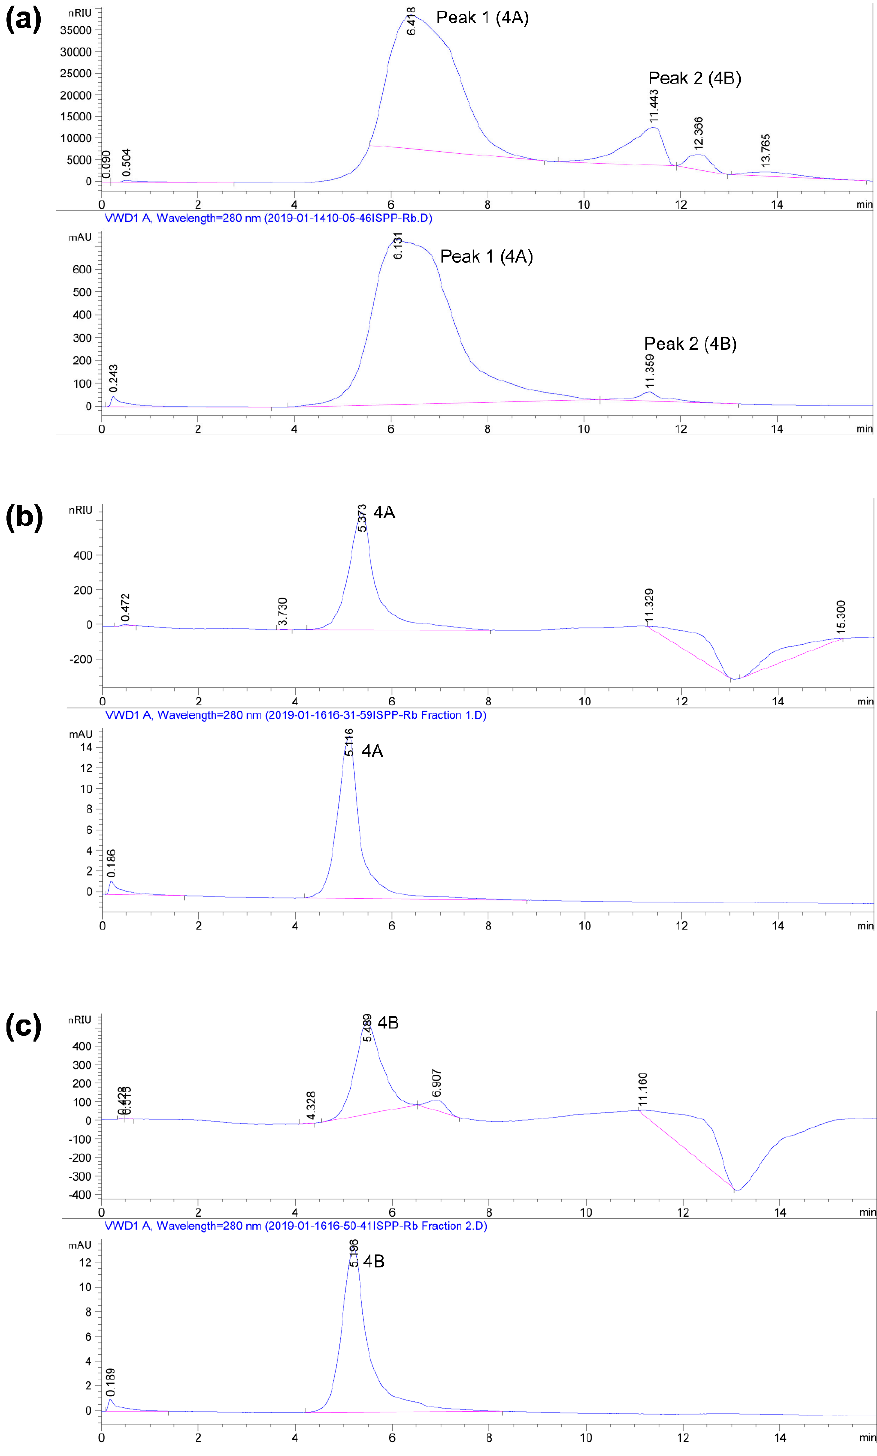
Figure 4. Purification of IMPP-Rb from R. badius using HPLC BioSEC5 (column 4). ( a ) Pooled, dialyzed, and lyophilized bioactive fractions from Sephacryl S-500 (column 3) were injected into BioSEC5. ( b ) Peak 1 (6–7.5 min) purified from ( a ) was reassessed for purity using BioSEC5. ( c ) Peak 2 (11–11.6 min) purified from ( a ) was reassessed for purity using BioSEC5. The top panel shows the refractive index spectrum and bottom panel indicates the UV spectrum at 280 nm.